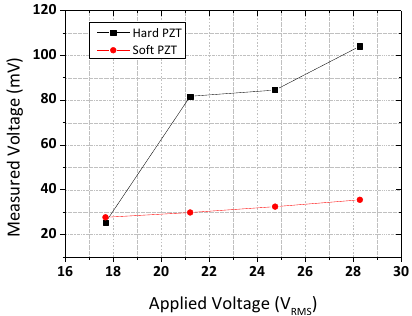
Figure 7. Variation in acoustic pressure delivered by the PZT transducer with voltage.